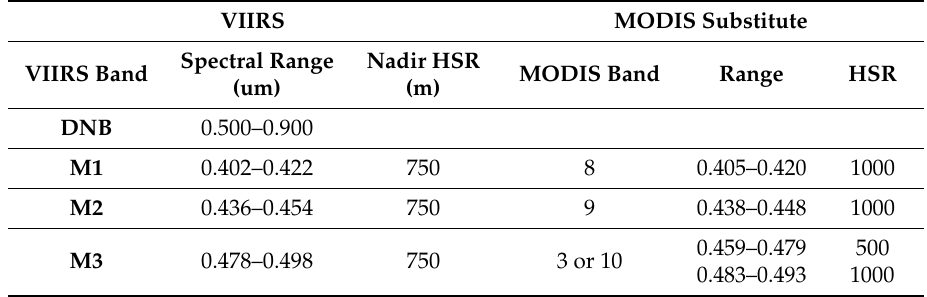
Table 2. MODIS and visible infrared imaging radiometer suite (VIIRS) spectral band wavelengths and nadir spatial resolutions (HSR: Horizontal spatial resolution)